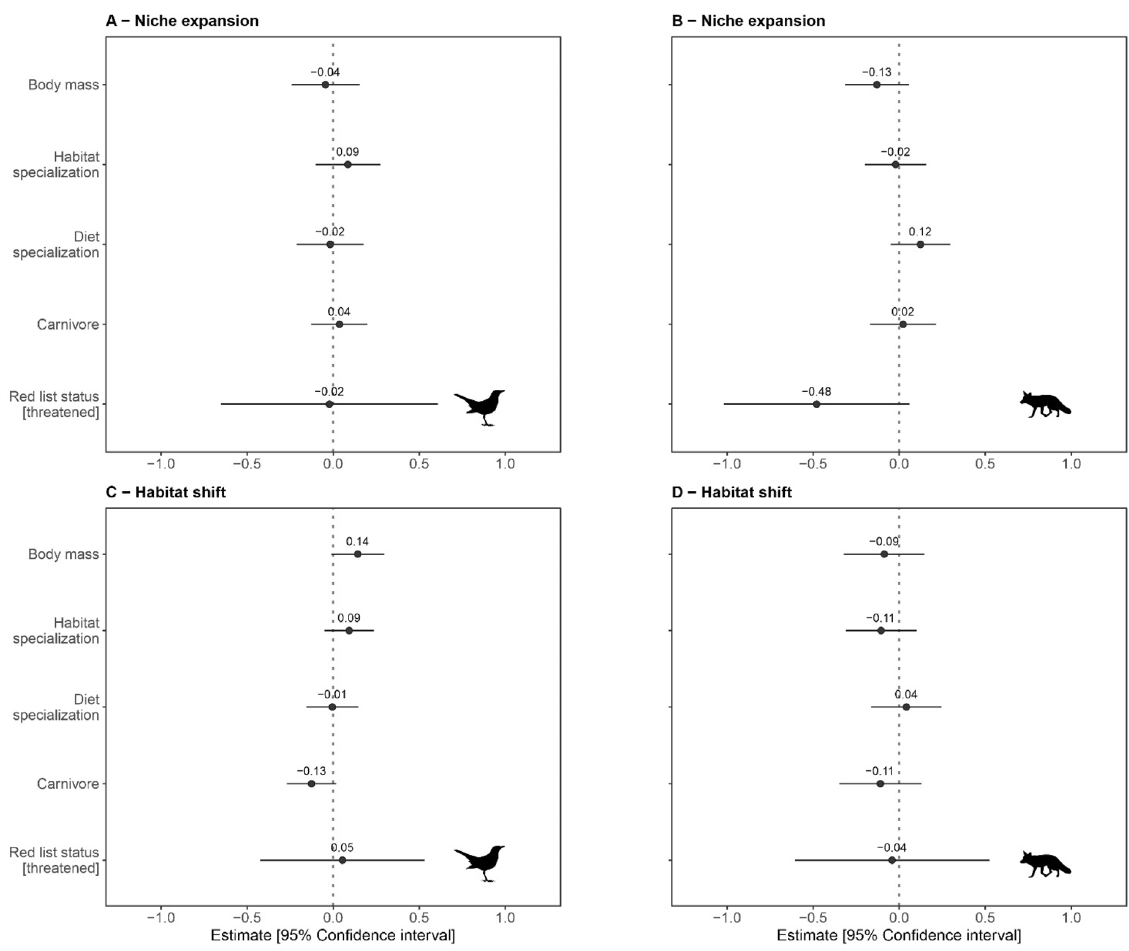
Figure 5. Relationships between species traits and ecological niche differentiation processes between protected and unprotected areas. ( A,B ) Represent niche expansion for birds and mammals, whereas ( C,D ) Represent habitat shift for birds and mammals, respectively. Each panel shows the estimated standardized coefficients β ± 95% CI, illustrating the effect of each trait. All continuous variables have been scaled to zero mean and 1 SD. For the red list status, the non-threatened status is used as a reference category. Carnivore indicates the proportion of the diet based on vertebrates (including endotherms and ectotherms). See Table S2 for the full test statistics